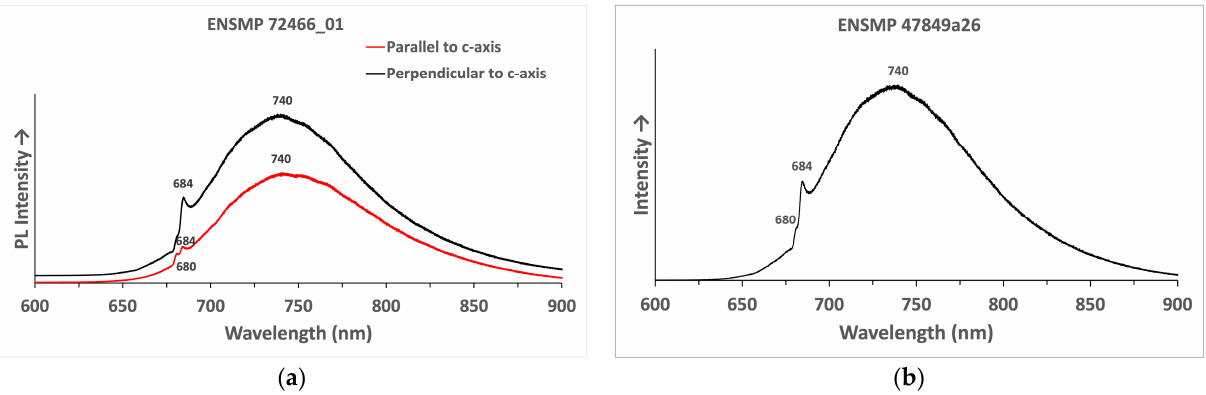
Figure 8. PL spectra of Egyptian emeralds (600–900 nm) from micro-Raman instrument. Sharp peaks near 680 nm are linked with Cr 3+ . Broad band at 740 nm is also associated with the presence of Cr. ( a ) PL spectra of a single-crystal emerald (ENSMP 72466_01) parallel (red line) and perpendicular (black line) to c-axis. The upper spectrum has been vertically offset for better clarity. ( b ) PL spectra of an emerald from a sample, which is included in the host rock (ENSMP 47849a26).